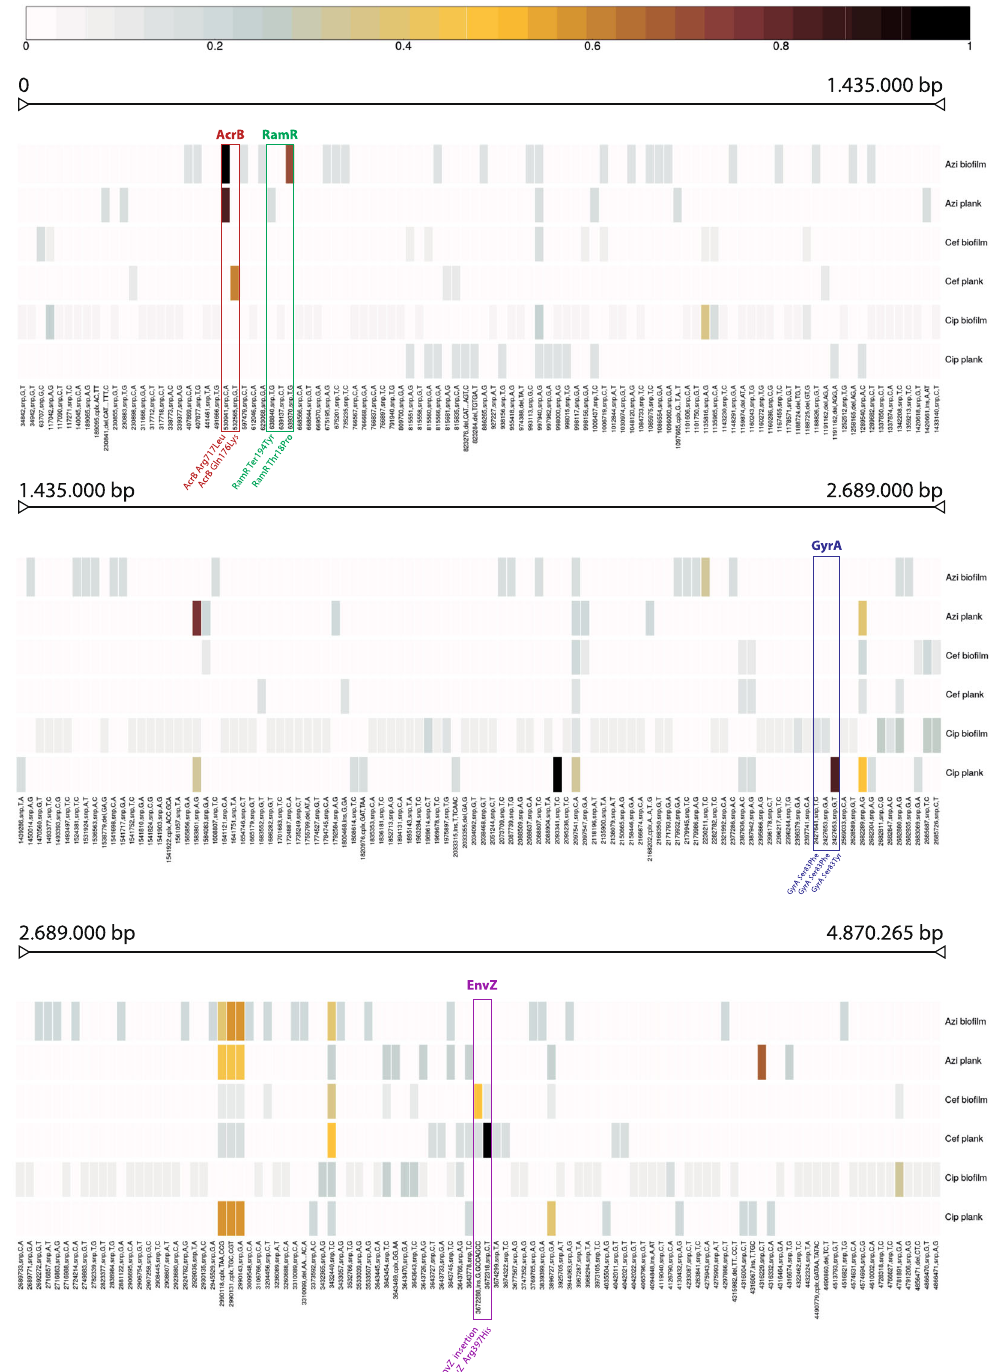
Fig. 4 Genetic variant distribution per genomic position. For each group (a combination of antibiotic exposure and bio fi lm formation), we calculated the average variant presence (SNPs, insertions, deletions, complex changes, etc.). The absence of the variant in all sequenced isolates is scored as zero (white), indicating that no samples had the variant. The presence in all isolates is scored as one (black), indicating its presence in all sequenced isolates. Intermediate values represent the fraction of samples where the variant was observed. The three panels represent three continuous sections of the